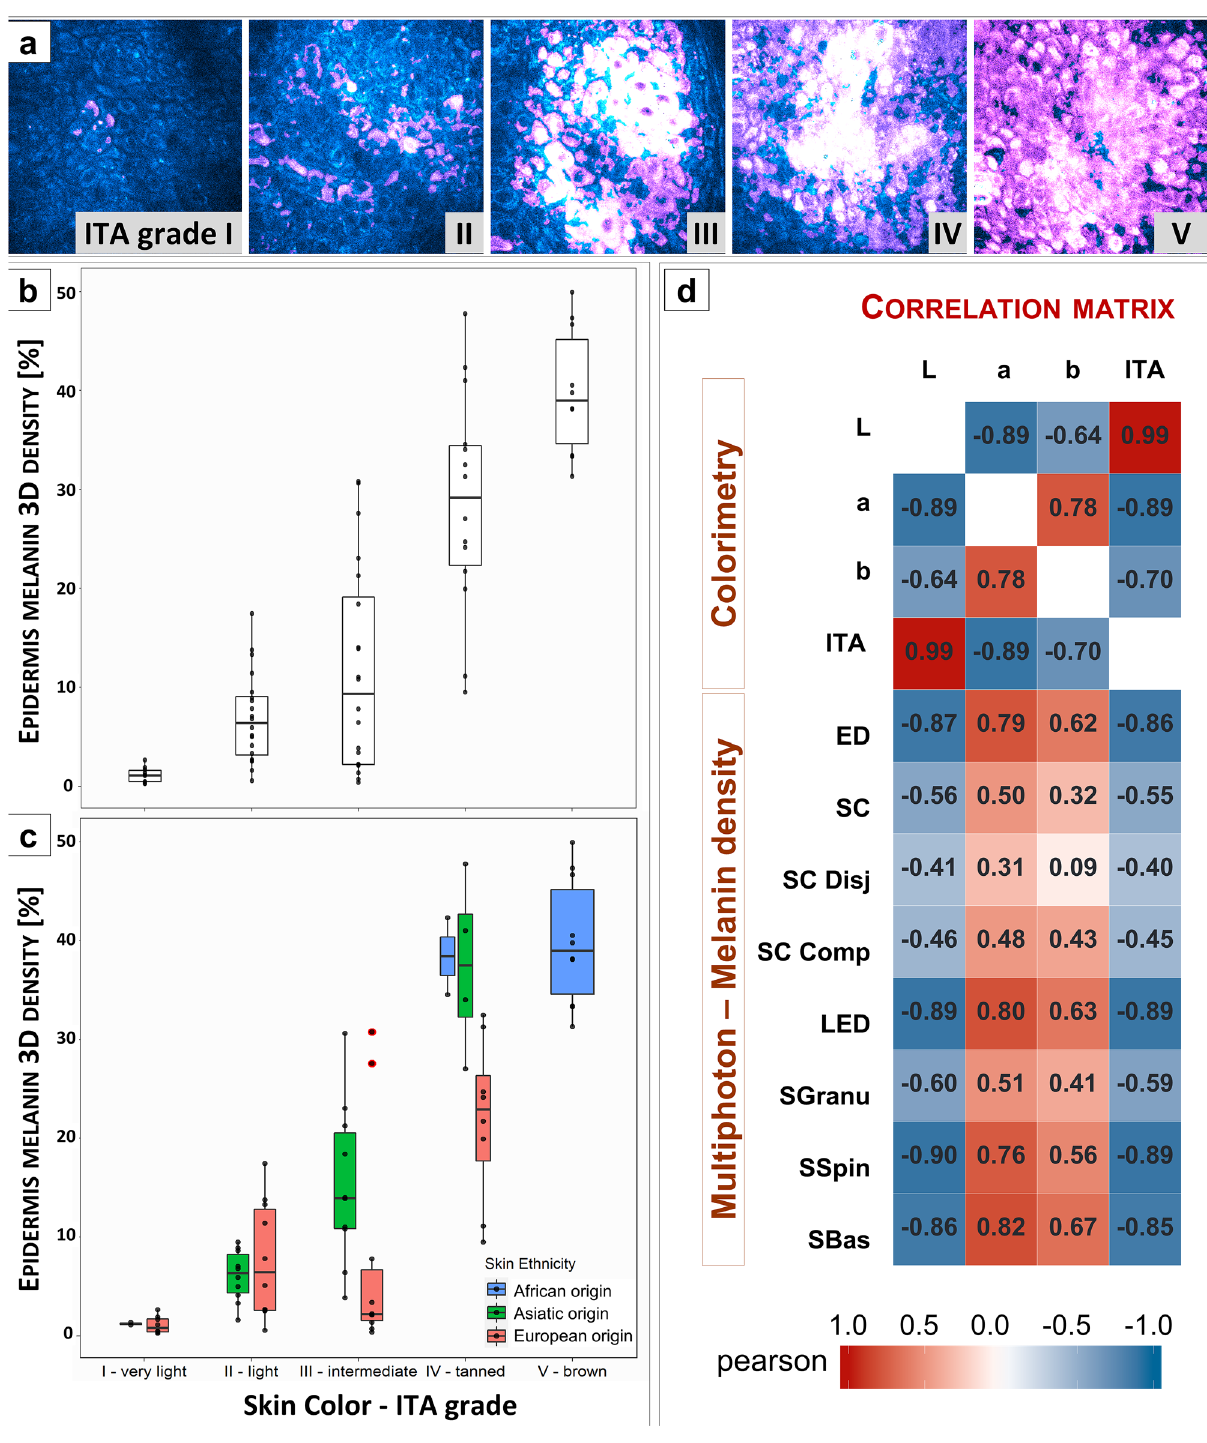
Figure 7. Modulation of global epidermal 3D melanin density with skin color ITA grade in constitutive pigmentation study. ( a ) Raw 2PEF intensity images (cyan hot) and Pseudo-FLIM melanin masks (purple) acquired within the basal layer of human forearm skin. High signal intensities appear in white color. ( b ) Modulation of 3D epidermal melanin density with ITA group and ( c ) with both ITA group and skin ethnicity. The data are expressed as boxplots with fences. ( d ) Correlation matrix of the skin colorimetric parameters and multiphoton melanin density estimated in the epidermis and its sub-layers. The data correspond to the Pearson correlation coefficients. An absolute value of the Pearson correlation coefficients between [0.6, 0.8] and [0.8, 1.0] indicate a strong and respectively a very strong correlation. ED (global epidermis), SC - stratum corneum , SC Disj - stratum corneum disjunctum , SC Comp - stratum corneum compactum , LED – living epidermis, SGranu - stratum granulosum , SSpin – stratum spinosum and SBas - stratum basale